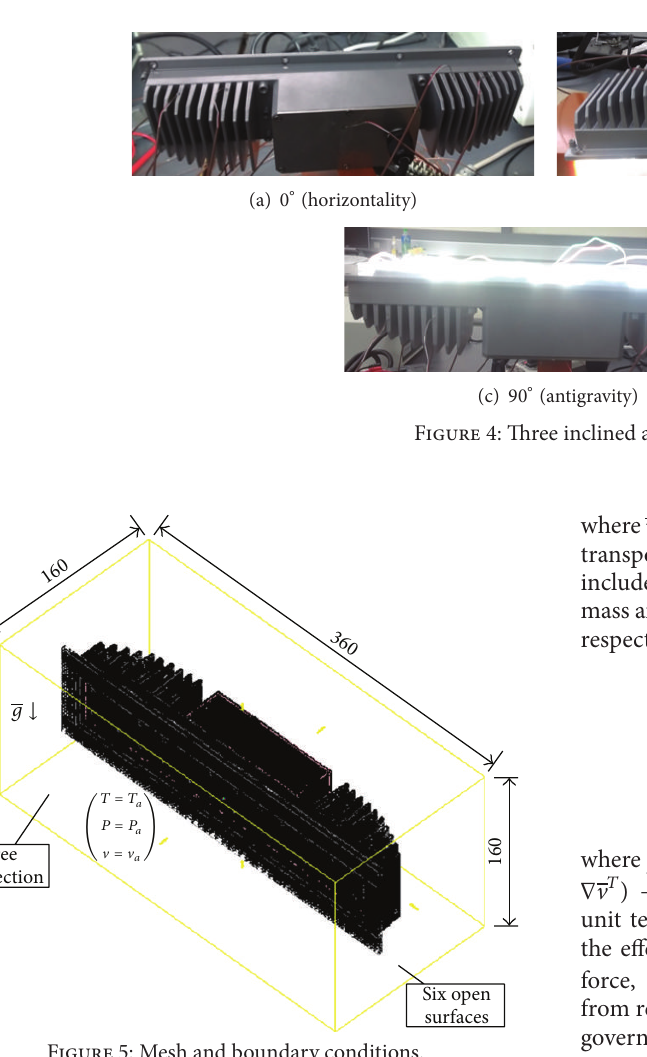
Figure 5: Mesh and boundary